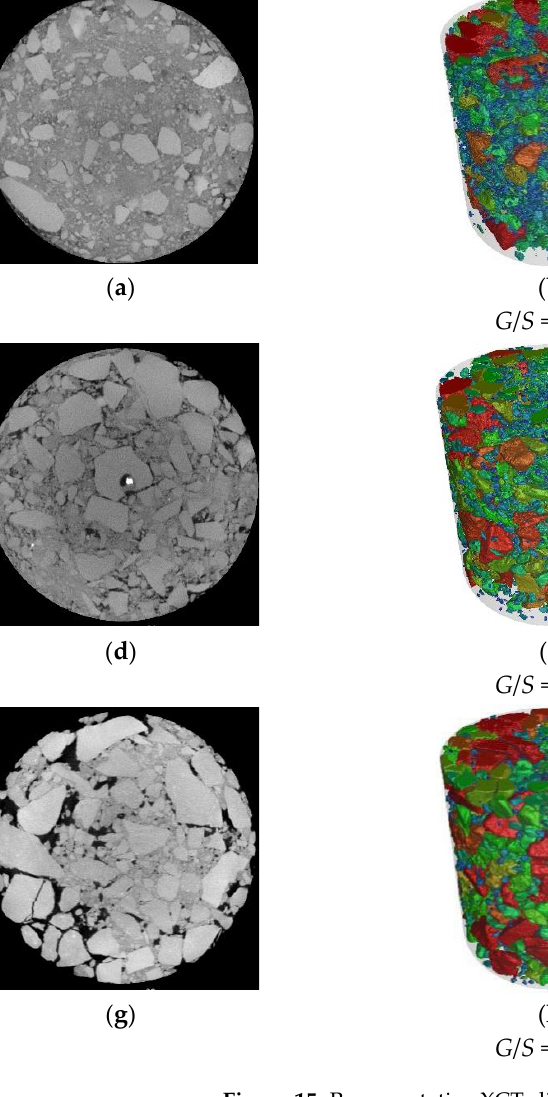
Figure 15. Representative XCT slices ( a , d , g ), reconstructed 3D model ( b , e , h ), and the equivalent Ball-Beam model ( c , f , i ) of UPAB specimens with different G / S levels (1.0, 1.8, and 2.5) during vibratory compaction from the left to the right for each row, respectively.